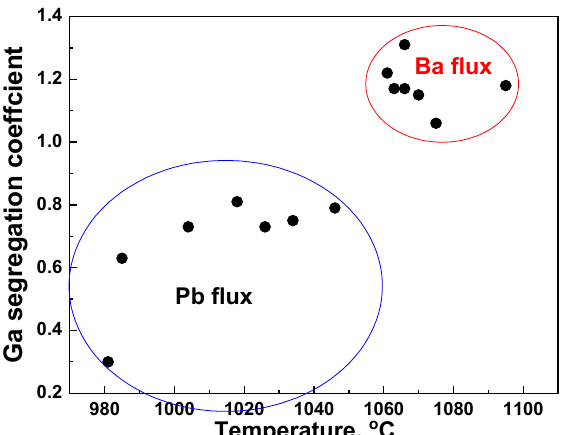
Figure 3. Ga segregation coefficients in (Tb,Al) 3 (Al,Ga) 5 O 12 :Ce SCFs deposited via the LPE method onto GAGG:Ce substrates, dependent on crystallization temperature.